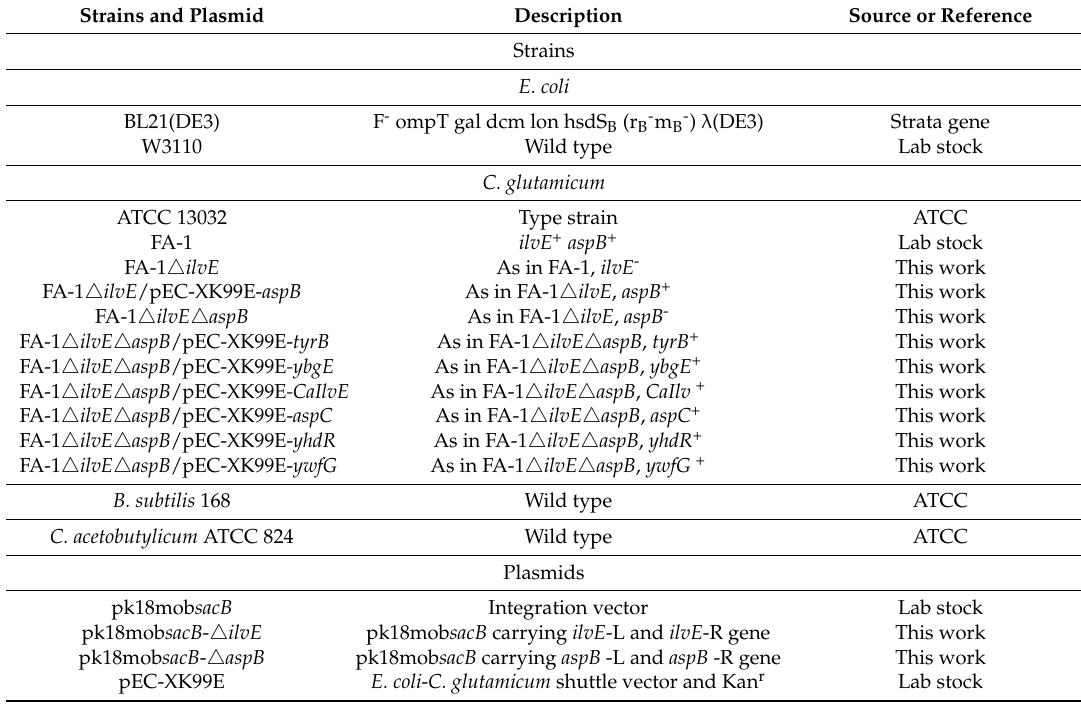
Table 4. Strains and plasmids